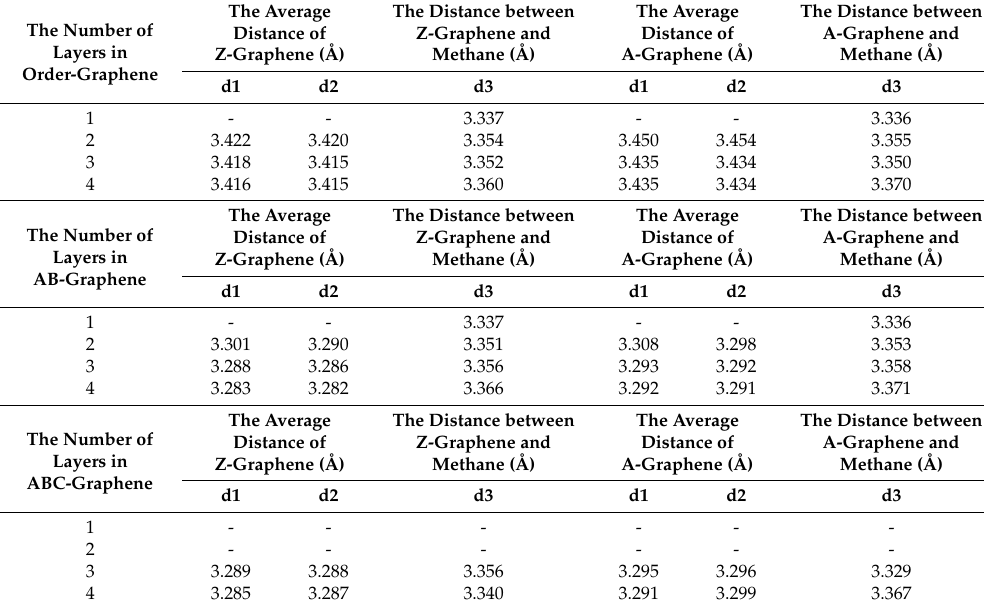
Table 3. The average interlamellar distance of optimized graphene (d1) and methane-graphene (d2) and the distance between graphene and methane